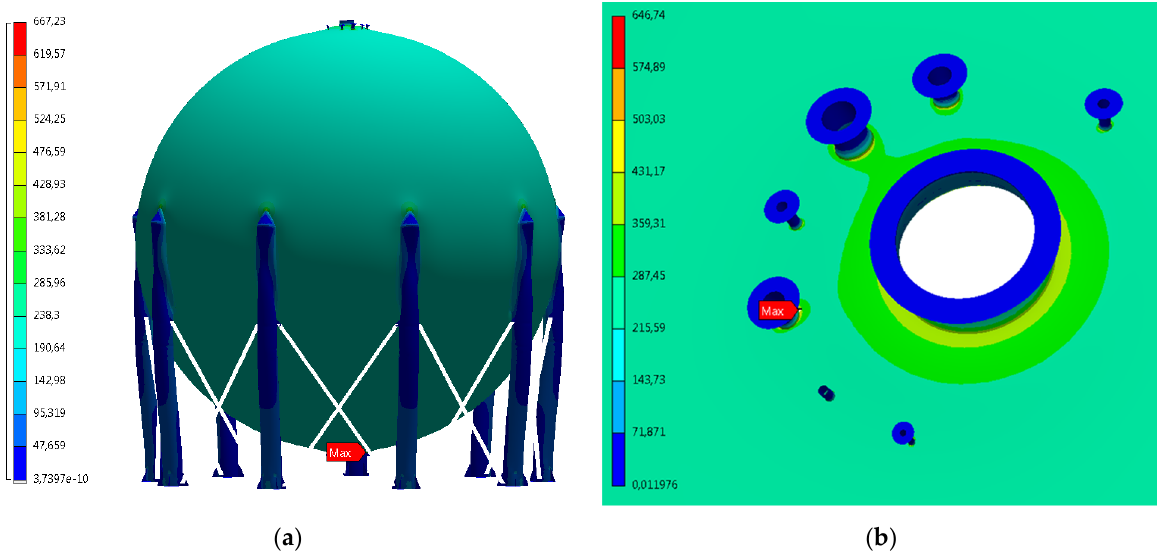
Figure 7. Equivalent von Mises stress contours [MPa] of the structure of the vessel for load case 5. View of the entire vessel ( a ), maximum stresses in the area of the stub pipe in the lower part of the vessel ( b ).